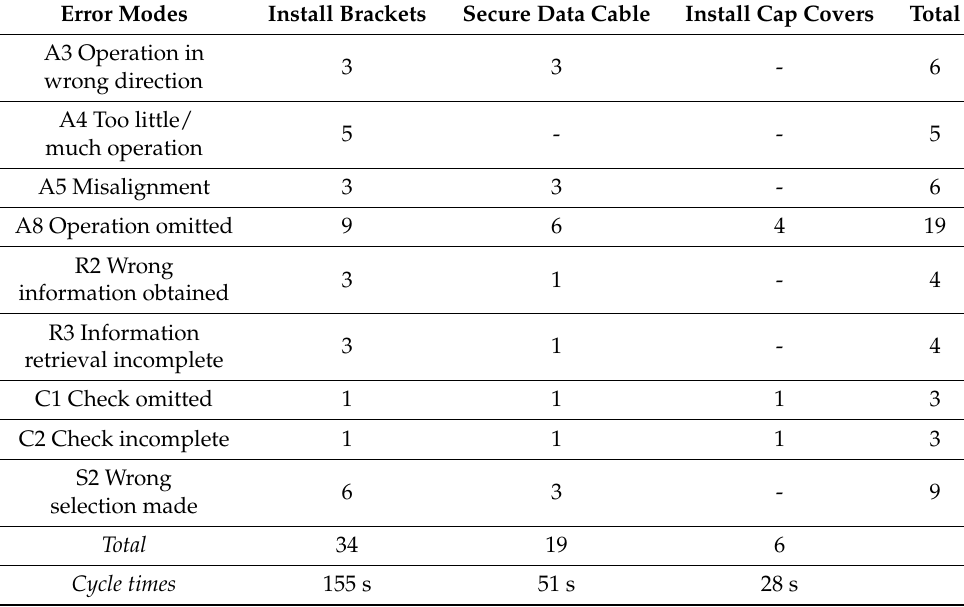
Table 3. Consolidated results of error modes obtained with SHERPA for the three critical tasks under study 1